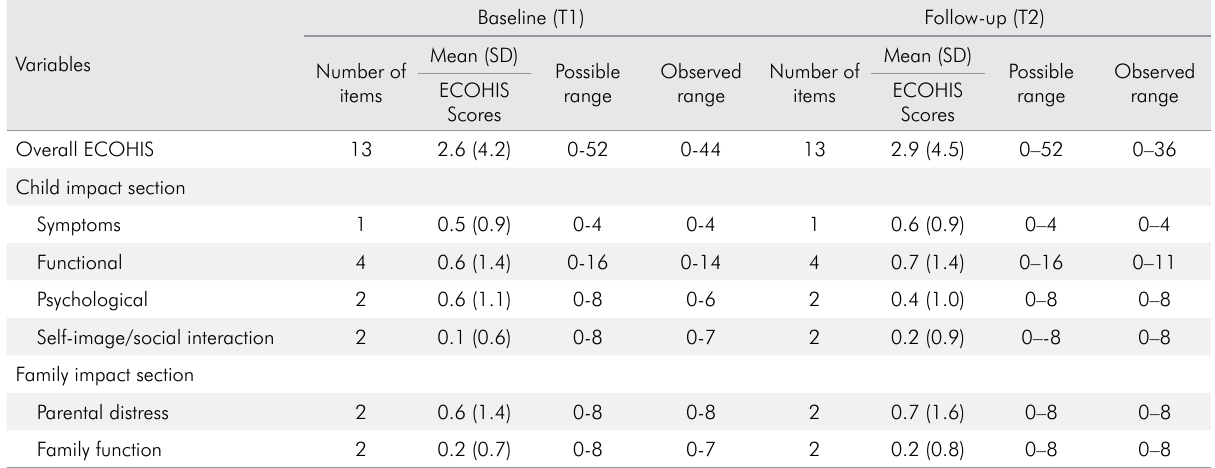
Table 2. Descriptive distribution of overall and domain-specific ECOHIS scores at baseline and 2-year follow-up.